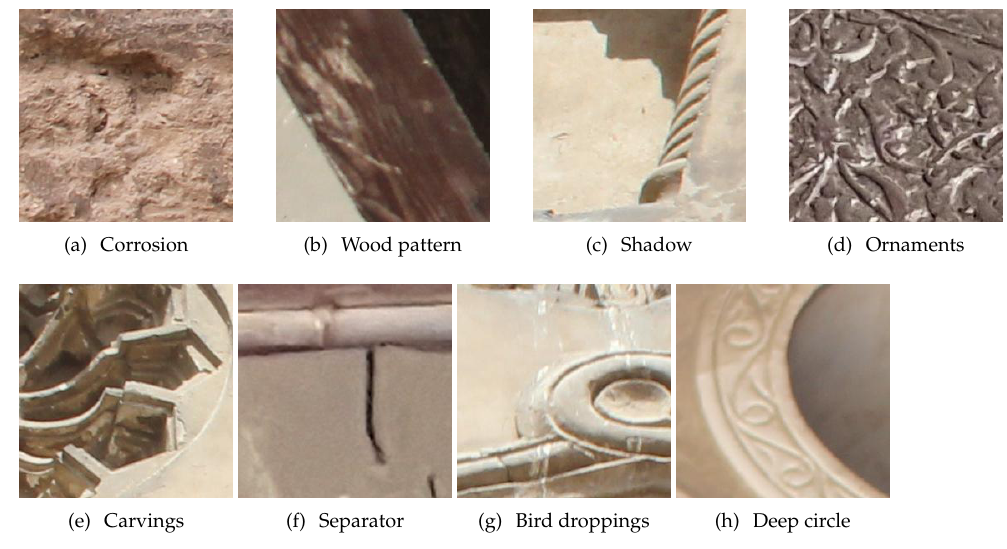
Figure 1. Historical building surface